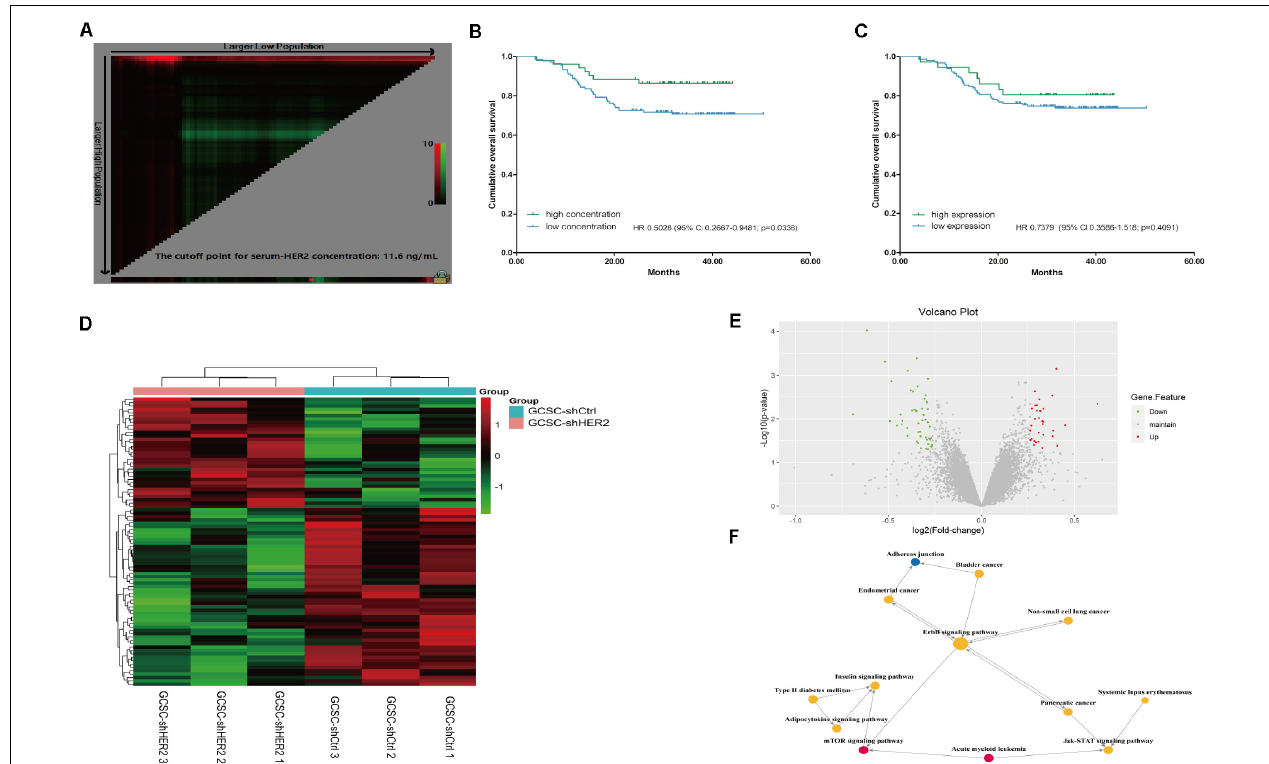
FIGURE 5 | Survival analyses and results of gene microarray and signaling pathway analysis. Picture (A) X-tile plots for serum concentration of HER2 in our study; the red spot shows the cutoff value (11.6 ng/ml) that separates the cohort into two groups. Picture (B) Survival analyses of patients with different serum concentrations of HER2; the result indicated that patients with high concentration of HER2 in serum had a favorable prognosis ( p = 0.0336). Picture (C) Survival analyses of patients with different expression levels of HER2 in tumor tissue ( p = 0.4091). Picture (D) Heatmap representation of the gene expression profiles of HER2-interfered GCSCs and control cells. Up-regulated expressions are marked in red; down-regulations are colored green; black reflects no difference in expression levels. Picture (E) The volcano plot of the gene microarray is used to evaluate the overall distribution of the differential gene between the HER2-interfered GCSCs and control cells. Green plots represent down-regulation mRNA genes while red plots represent up-regulation mRNA genes with a fold change > 1.2 and p value < 0.05. Picture (F) Signaling pathway analysis revealed that HER2 gene might regulate the signal transduction of mTOR, Jak-STAT, and other signal pathways. Yellow circles represent pathways with up-regulation and down-regulation mRNA genes. Pathways that only contain up-regulation mRNA genes were marked with a red circle, while the blue one represents pathway that involves down-regulation mRNA genes. The size of circles shows the value of